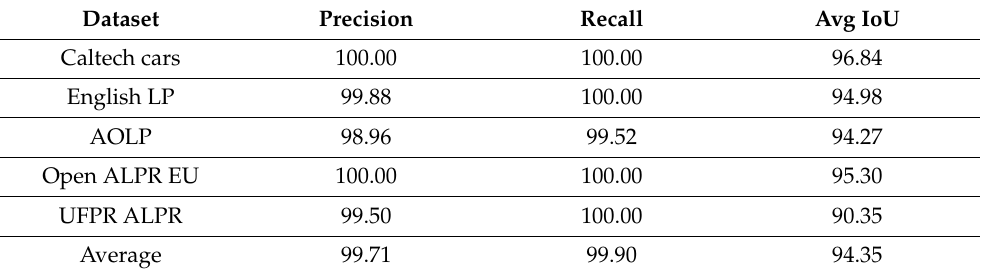
Table 5. Results attained in vehicle detection (%) and the recall rates achieved in all datasets. Dataset Precision Recall Avg IoU Caltech cars